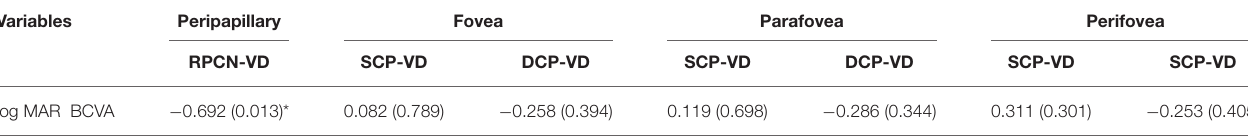
TABLE 5 | The Results of Pearson Correlation Analyses between log MAR BCVA and Vascular Densities in BU Group. Variables